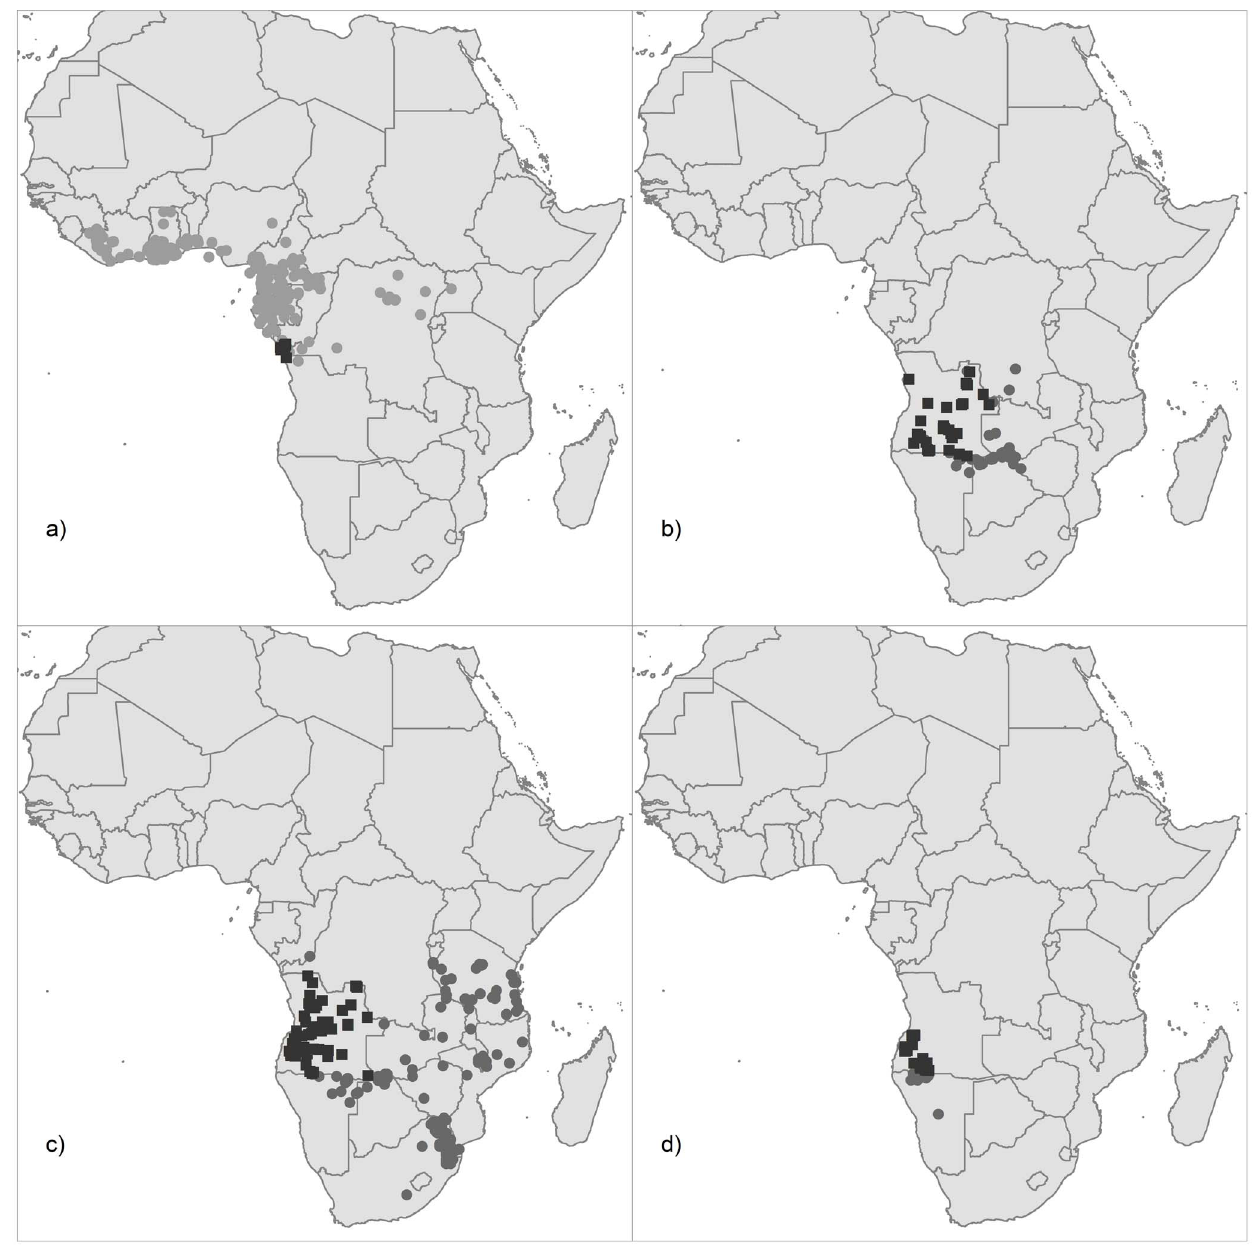
Figure 3. Geographic distribution in Africa of representative timber trees from Angola. ( a ) Species typical of Guineo-Congolian rainforests that reach their southern limit in Cabinda ( E. cylindricum; E. utile; G. arnoldiana; G. balsamiferum; K. ivorensis; O. oxyphyllum; T. superba ); and species with . 15% of their global range concentrated in Angola, including ( b ) G. coleosperma , ( c ) P. angolensis , ( d ) E. spicatum . Black squares: studied specimens from Angola, housed in LISC, LISU, COI, BM and K; grey circles: data obtained via the GBIF portal.